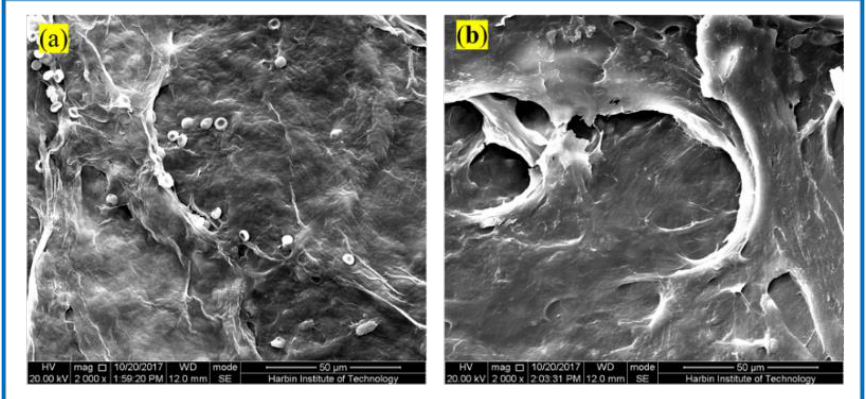
Figure 8. SEM photos taken 3 weeks after composite scaffolds embedded in vivo: ( a ) pristine BC